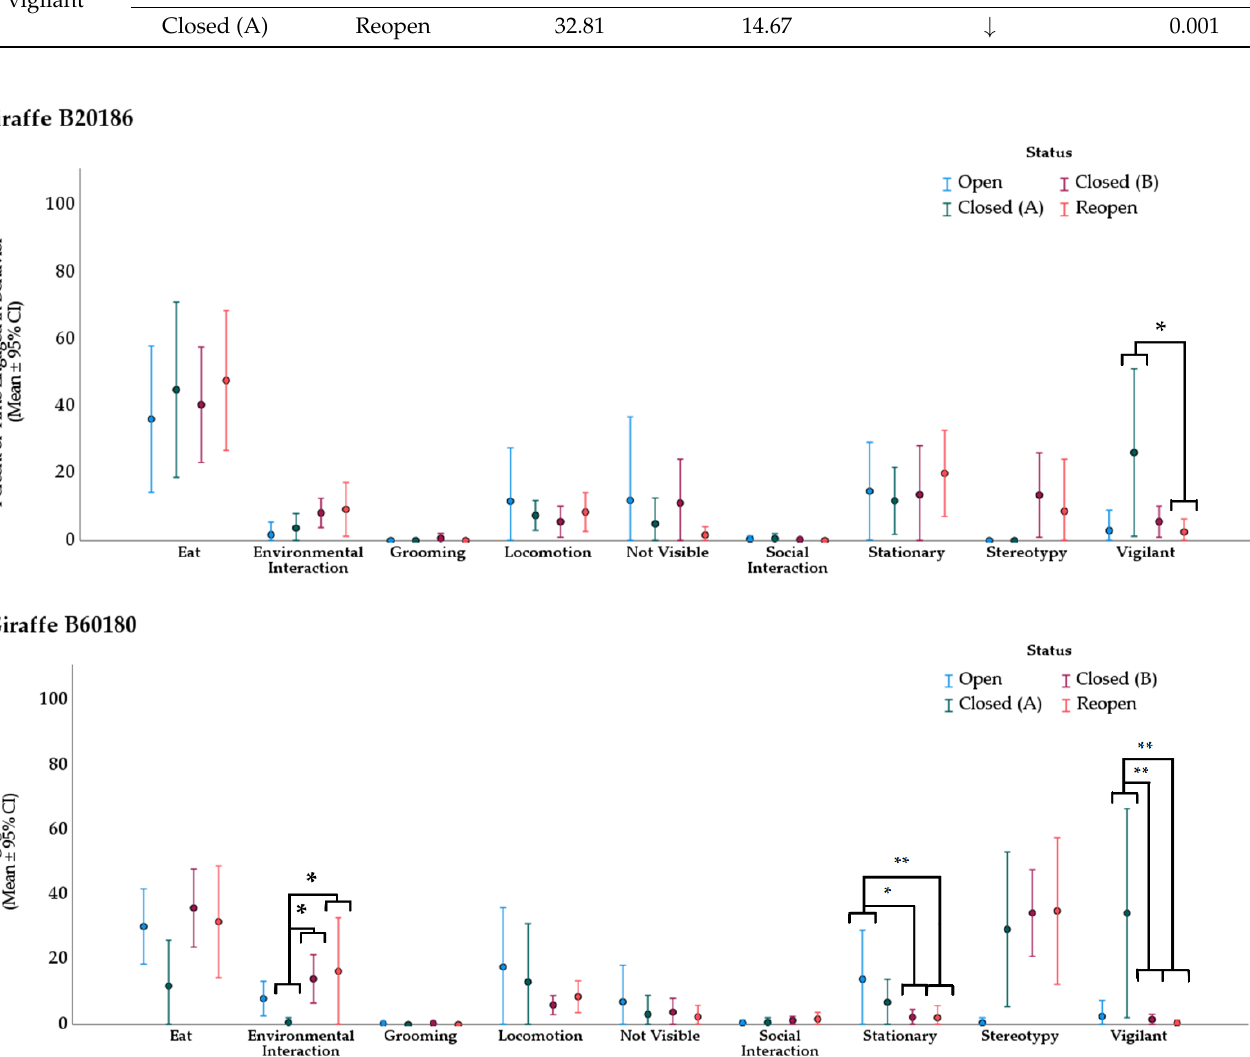
Figure 4. Giraffe average behavior expression proportion (%). Proportion indicates percent of total observation time conducting the behavior. Error bars are 95% confidence intervals. Asterisks (*): significance at α = 0.95, (**): significance at α = 0.90. Observations in category “Open” were 60-minutes and conducted by volunteers. All others were 20-minutes and conducted by the first author.